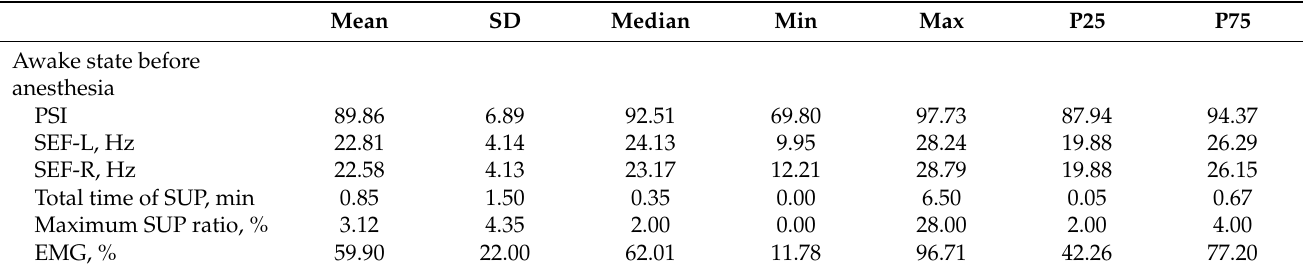
Table 3. EEG parameters in patients with Parkinson’s disease in the three states during deep brain stimulation in the subthalamic nucleus ( n =